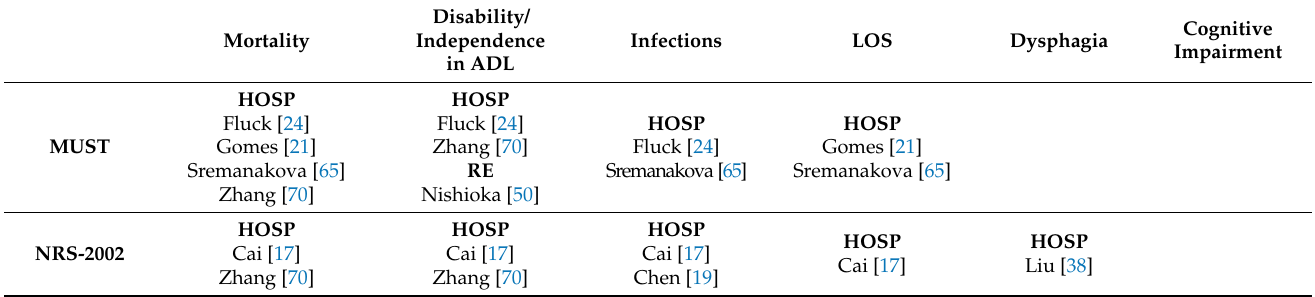
Table 2. Principal outcomes related to nutritional risk (various screening tools) among stroke